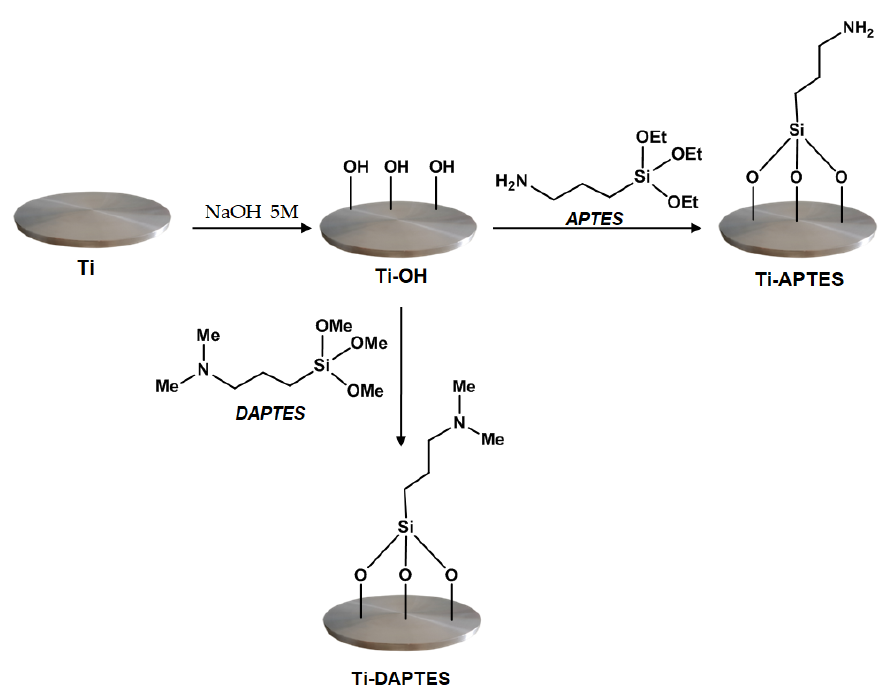
Figure 1. Activation and silanization of titanium discs surfaces.